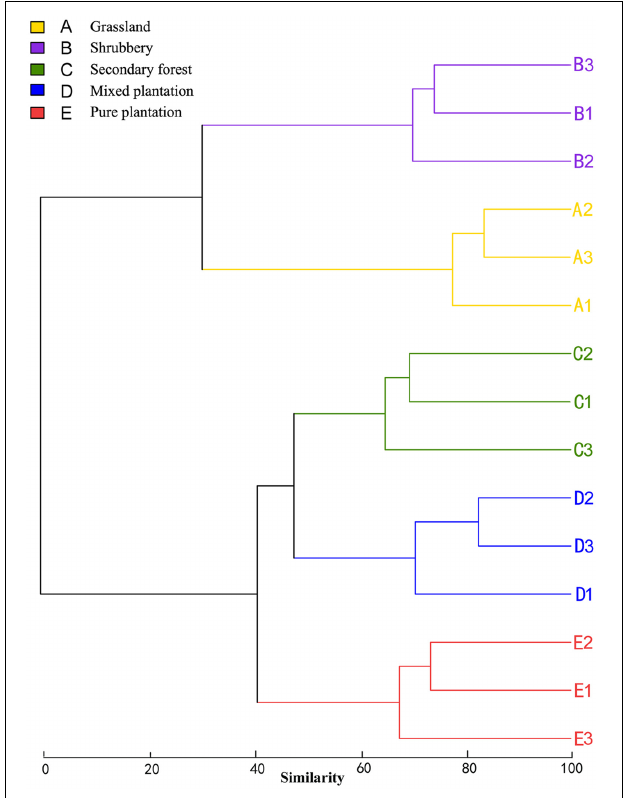
FIGURE 1 | Clustering analysis of bacterial communities under five vegetation types based on OTU abundance-based Bray-Curtis similarity coefficients.